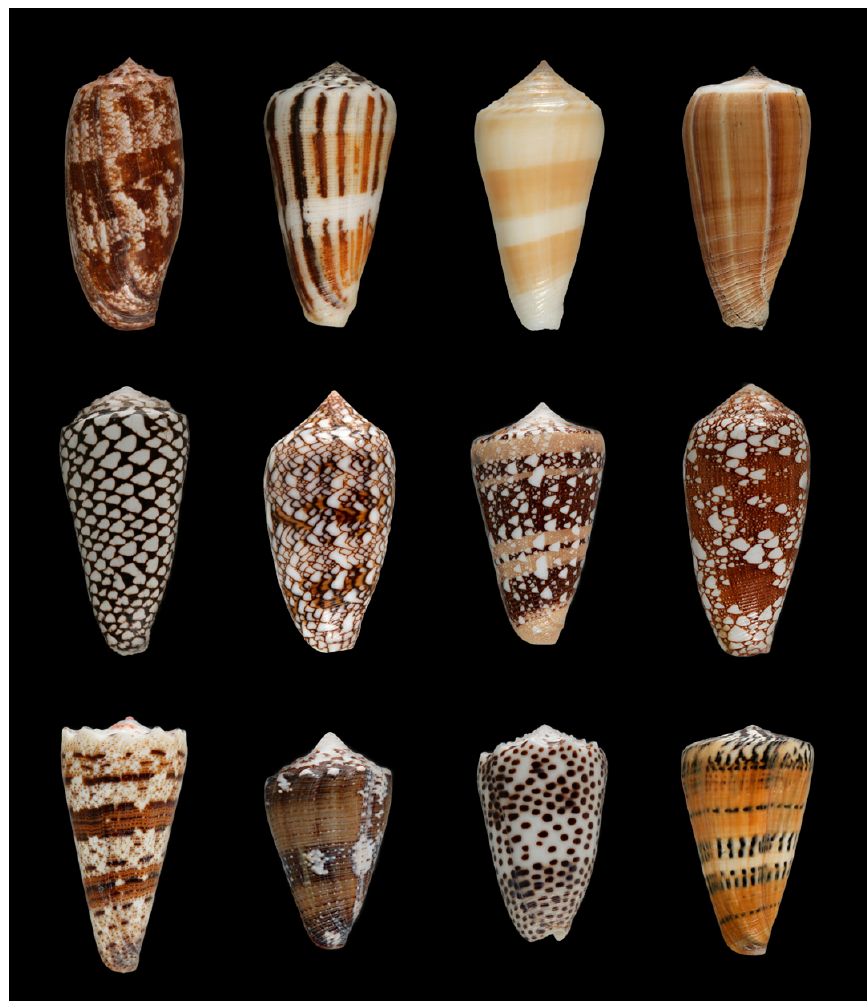
Figure 1. Shells of selected cone snail species from nine subgenera (for subgenus classification see [5]). Top row: fish-hunting cone snails (from left to right: Conus geographus ( Gastridium ), Conus magus and Conus consors ( Pionoconus ), Conus purpurascens ( Chelyconus )), middle row: snail-hunting cone snails ( Conus marmoreus ( Conus ), Conus textile and Conus ammiralis (Cylinder ), Conus omaria ( Darioconus )), bottom row: worm-hunting species ( Conus imperialis and Conus regius ( Stephanoconus ), Conus pulicarius ( Puncticulis ), Conus mustelinus ( Rhizoconus )). Shells not to scale.